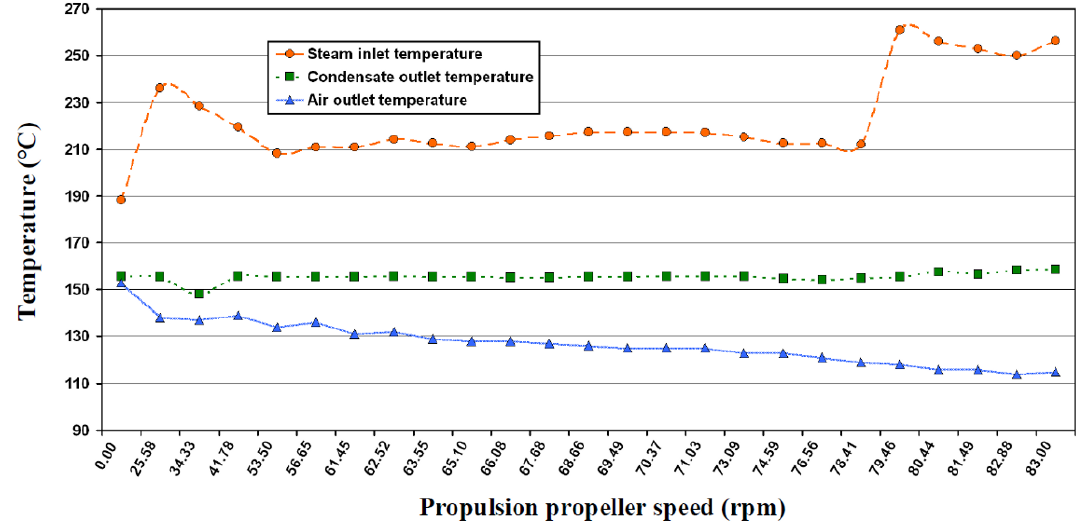
Figure 4. Temperature change of three operating substances through steam air heater.